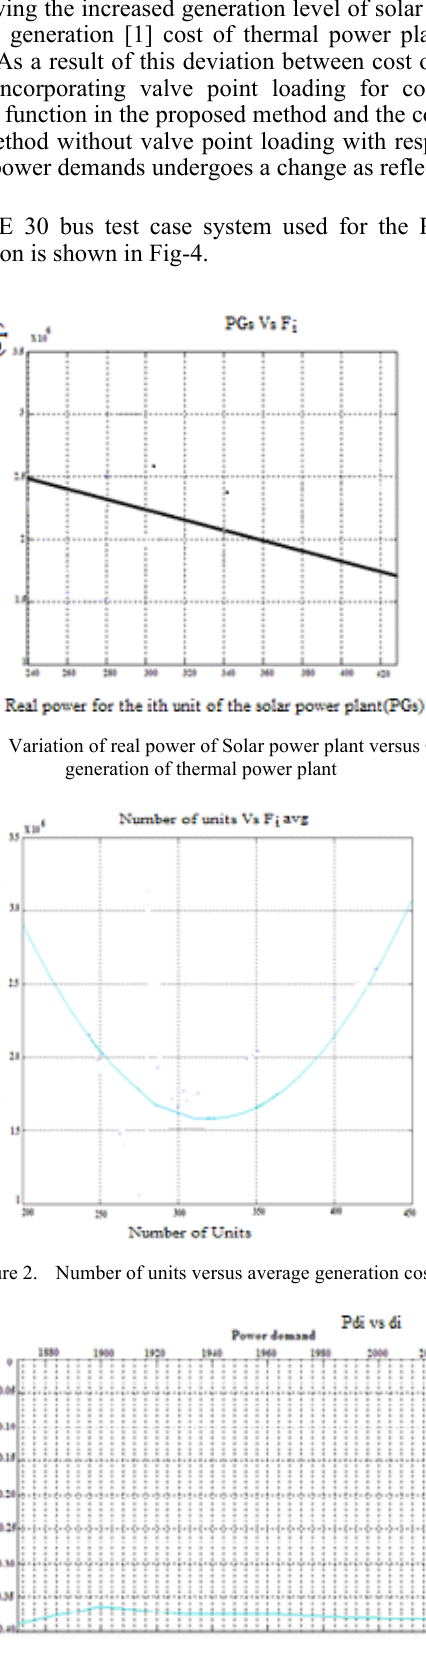
Figure 3. Power demand versus